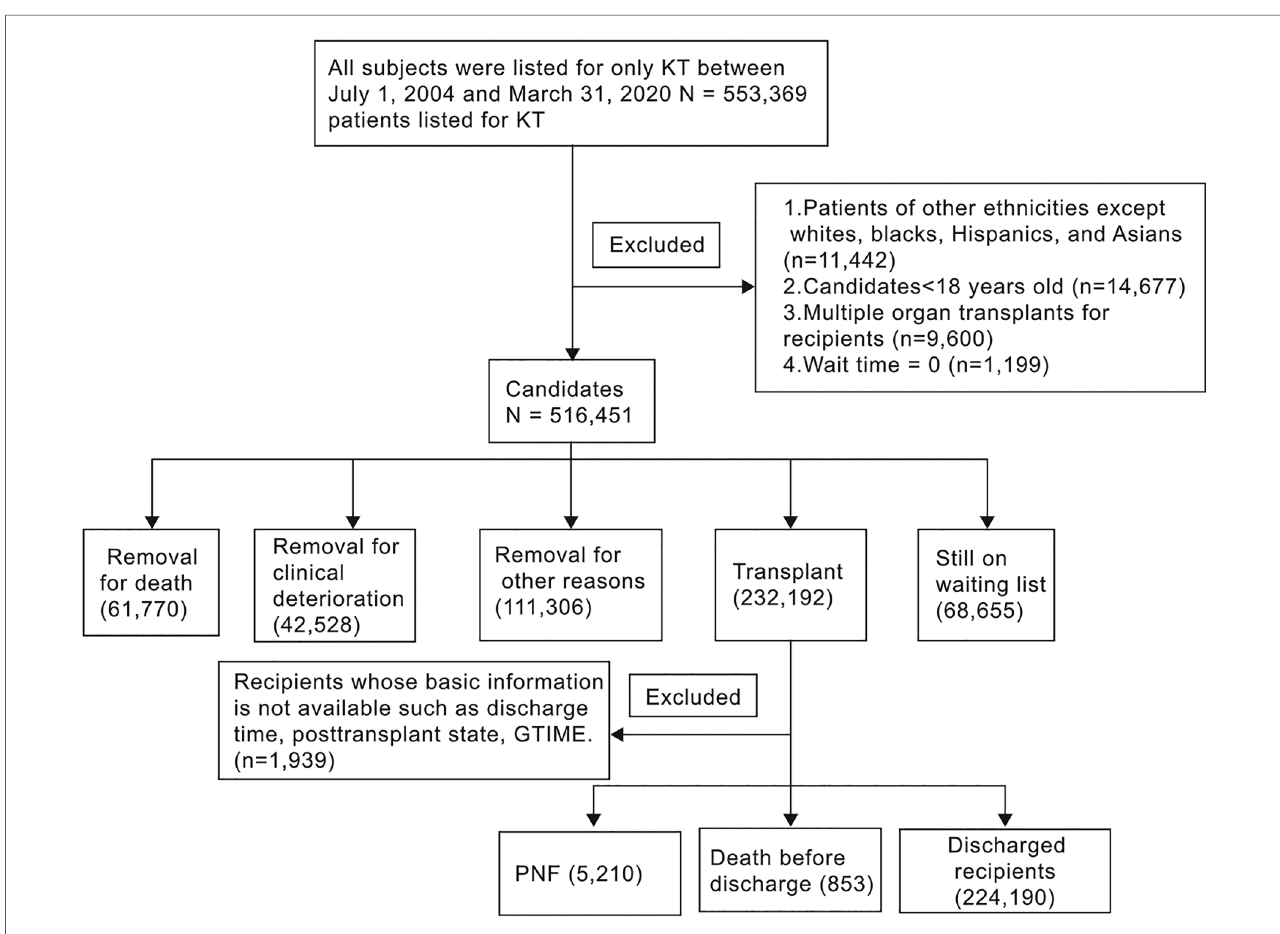
FIGURE 1 Flow diagram of the study participants. KT: kidney transplant; PNF: Primary nonfunction. Note: 1. GTIME, a variable derived from UNOS, indicates graft lifespan-kidney-days from transplant to failure/death/last follow-up; 2. Of the 853 deaths, 836 were simultaneously diagnosed with